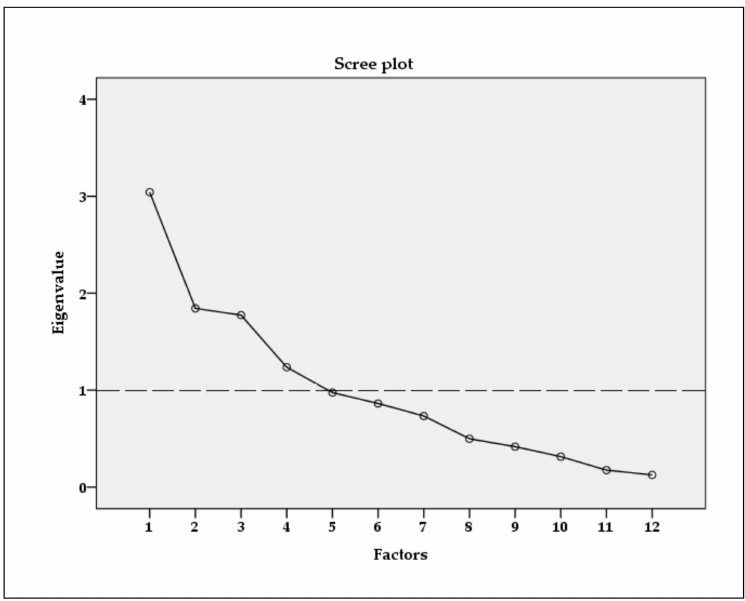
Figure 3. The scree plot and eigenvalues of PCA. Based on the eigenvalues and scree plot, principal component analysis (PCA) generated four principal